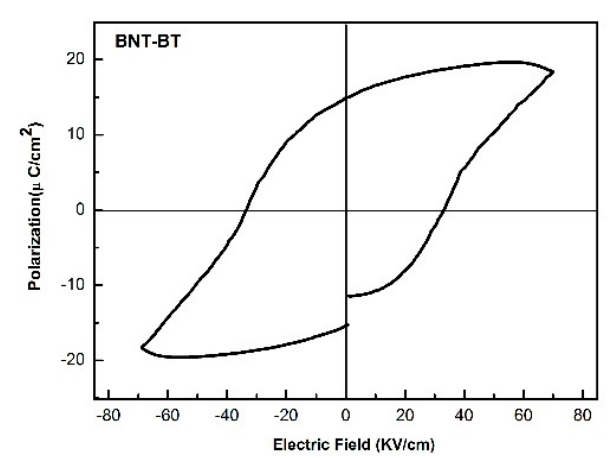
Figure 5. The P-E hysteresis loop of BNT-BT thick film.